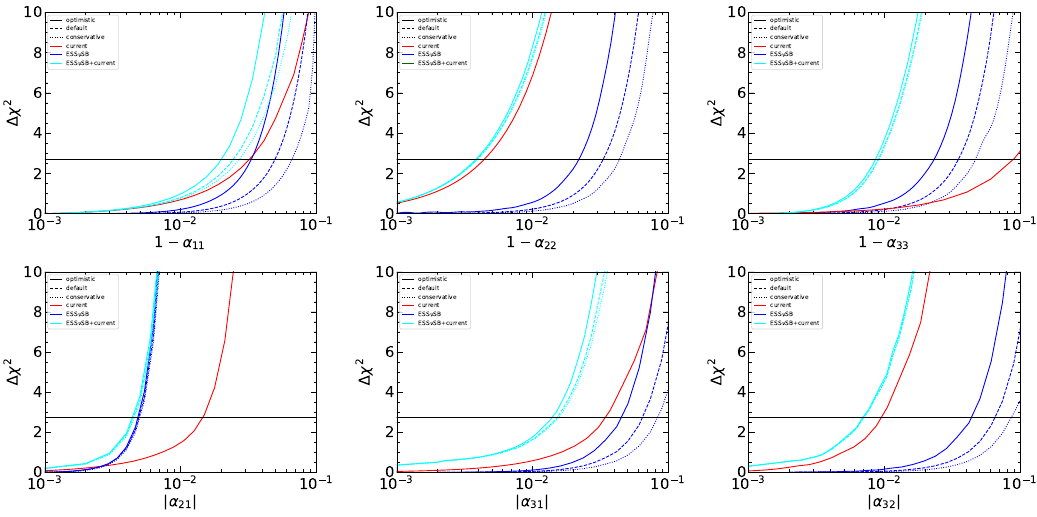
Figure 6 . The ∆ χ 2 profiles for the ESS ν SB sensitivity for the 2-detector analysis including NC channels to the nonunitarity parameters (blue), in comparison with the profiles obtained in ref. [44] (red) and the profiles that could be obtained from a combined analysis of current data and ESS ν SB (cyan) for different assumptions on the systematic uncertainties. The horizontal solid black line shows the ∆ χ 2 = 2 . 71 corresponding to 90% C.L.